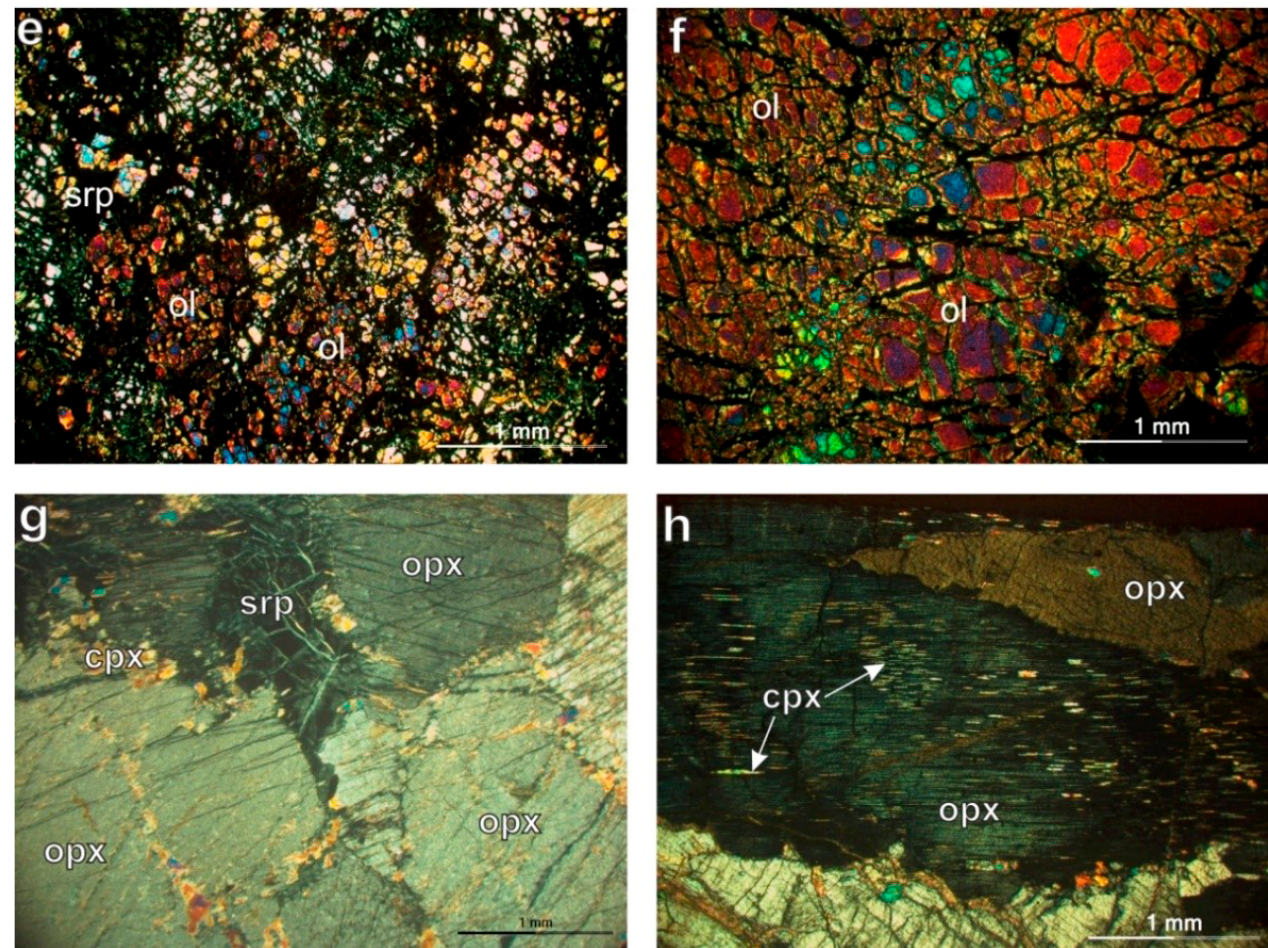
Figure 4. Photomicrographs of: ( a , b ) porphyroclastic and cataclastic texture of lherzolite with porphyroclasts of orthopyroxenes showing kink banding, crystals of olivine and clinopyroxene showing undulate extinction (sample SG1, SG2, XPL); ( c ) spinels with engraved margins in cataclastic harzburgite (sample SG8, XPL); ( d ) porphyroclasts of orthopyroxene and olivine crystals with undulate extinction in harzburgite (sample SG8, XPL); ( e ) granular texture of fine grained dunite with low percentage of serpentine (sample SG10, XPL); ( f ) granular texture of dunite (sample SG9, XPL); ( g ) a small percentage of serpentine with mesh texture in pyroxenite (sample SV1, XPL); ( h ) exsolution lamellae of clinopyroxene in pyroxenite (sample SV2, XPL). Abbreviations: ol: olivine, opx: orthopyroxene, cpx: clinopyroxene, srp: serpentine, sp: spinel.